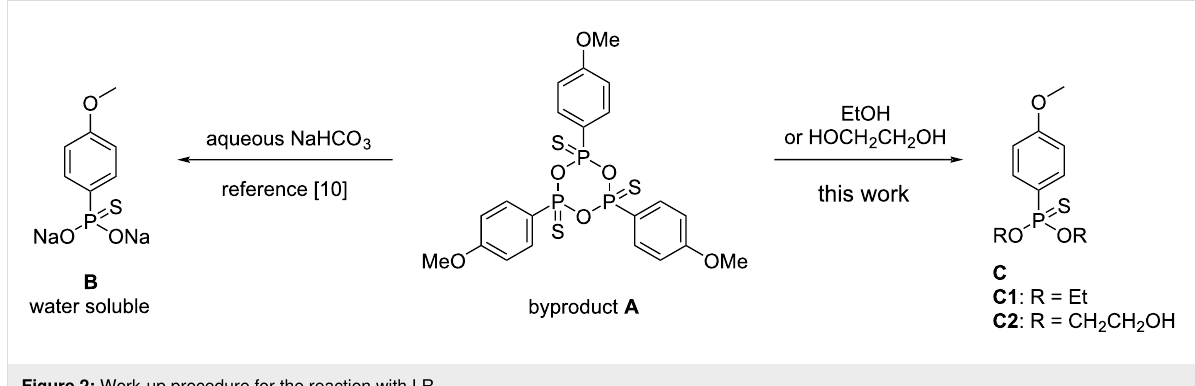
Figure 2: Work-up procedure for the reaction with